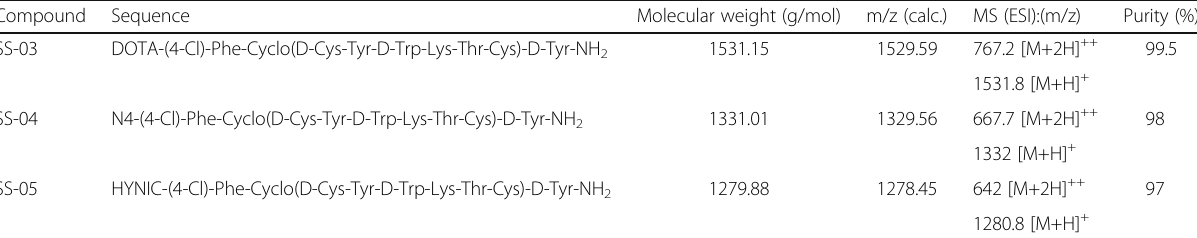
Table 1 Analytical data of the purified chelator-peptide conjugates Compound Sequence Molecular weight (g/mol) m/z (calc.)